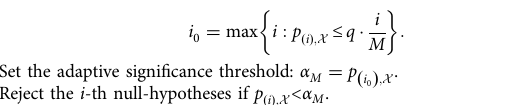
Figure 7 presents an experiment on real codon data, visualizing how the p-values calculated by our method correspond to expected differences between codons. Mathematical Tools Torus mean . Given a set of N points on a torus φ i S 1 ´ S 1 , we would like to calculate the mean of these points, (cid:2) φ in a way which accounts for the wrap-around of each angle at ±180°. We de fi ne a function which approximates a centroid on a torus, by calculating the average angle with circular wrapping in each direction separately. We denote this function as